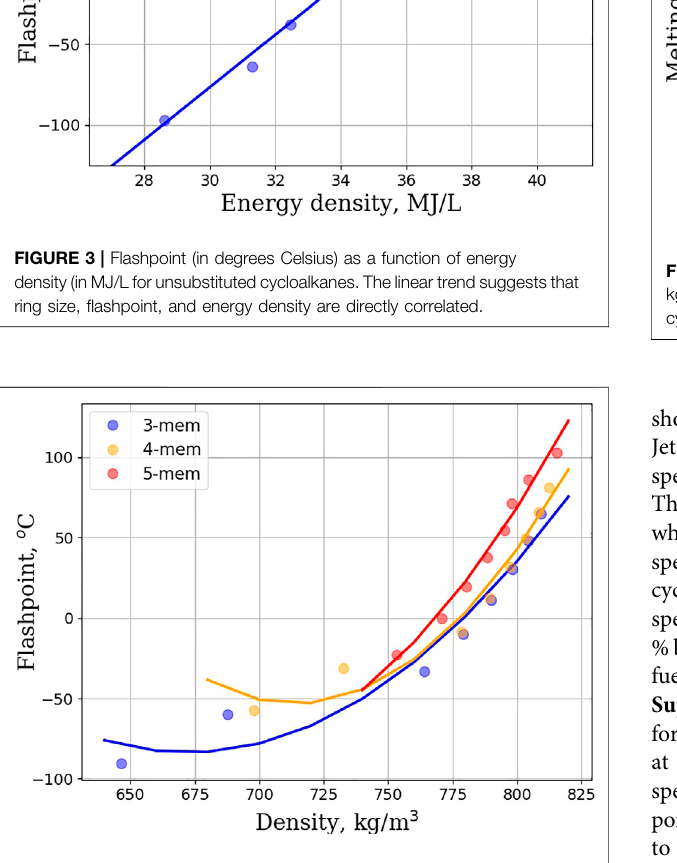
FIGURE4| Flashpoint(indegreesCelsius)asafunctionofdensity(inkg/ m 3 ) for monosubstituted linear cycloalkanes. Data are shown for 3, 4, and 5 membered rings, and are fi tted to a second order polynomial. Each curve is plotted, starting from methylcycloalkane, and increasing the size of the alkyl group by 1 carbon with each successive point.